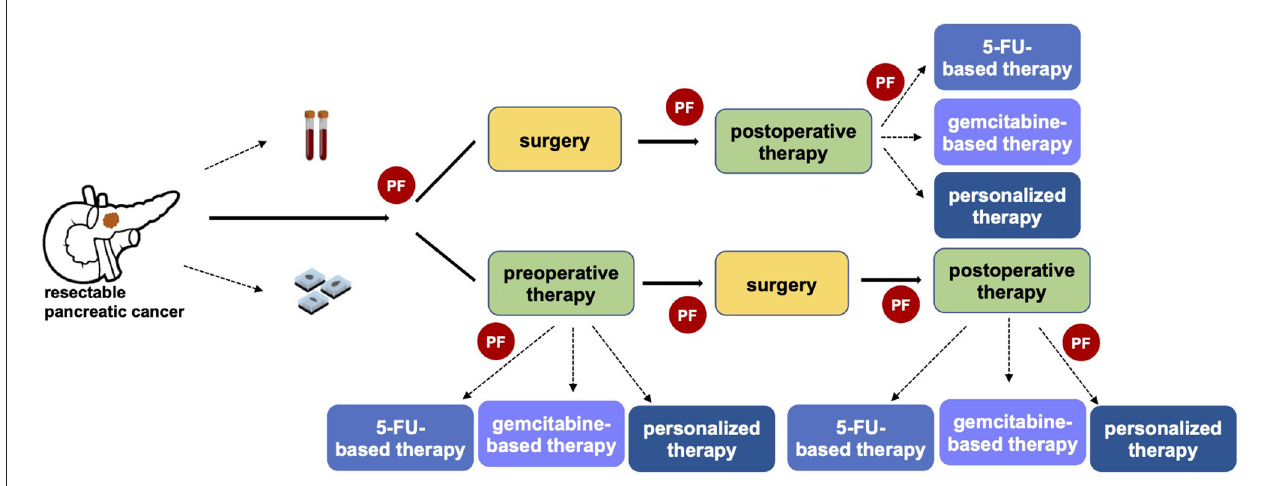
FIGURE 1 | The importance of predictive factors in defining a personalized clinical approach in resectable pancreatic cancer. The identification of predictive factors (PF) has a central role in driving the therapeutic strategy, both in referring patients toward upfront surgery or preoperative therapy and in the choice of the optimal systemic pre- and post-operative